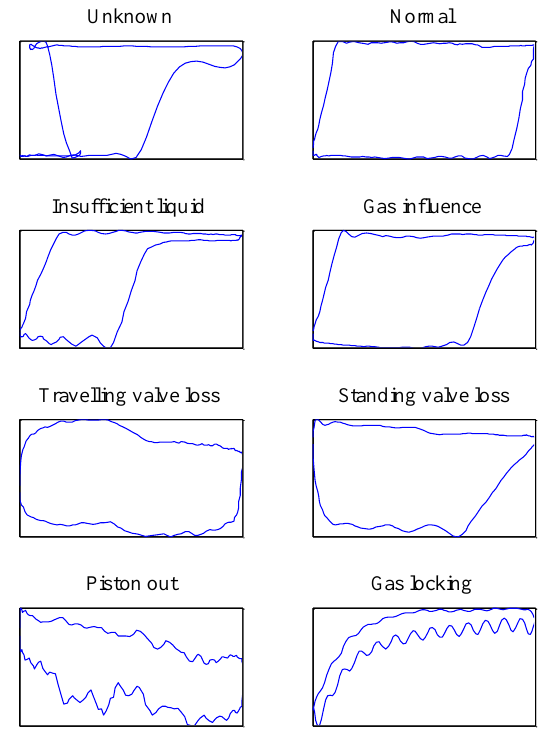
Figure 3—The typical indicator diagram.